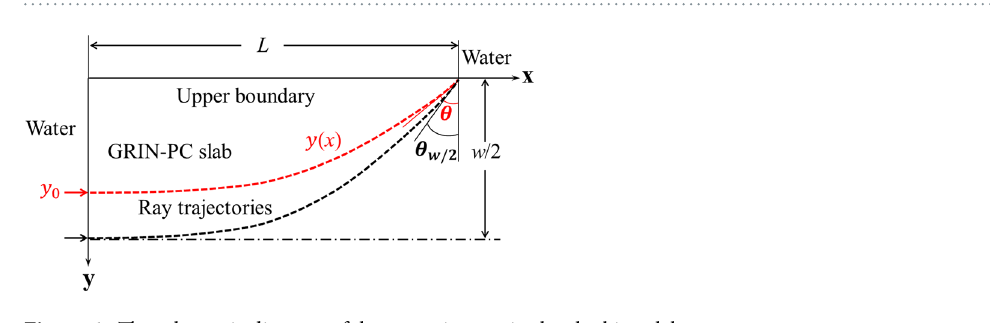
Figure 6. The schematic diagram of the ray trajectory in the cloaking